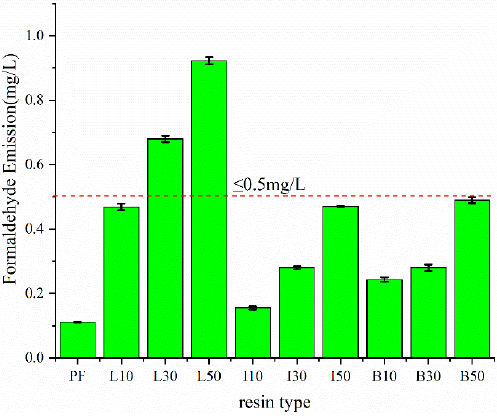
Figure 11. Formaldehyde emission of PF, ALPF, and DLPF resins at different lignin substitutions.